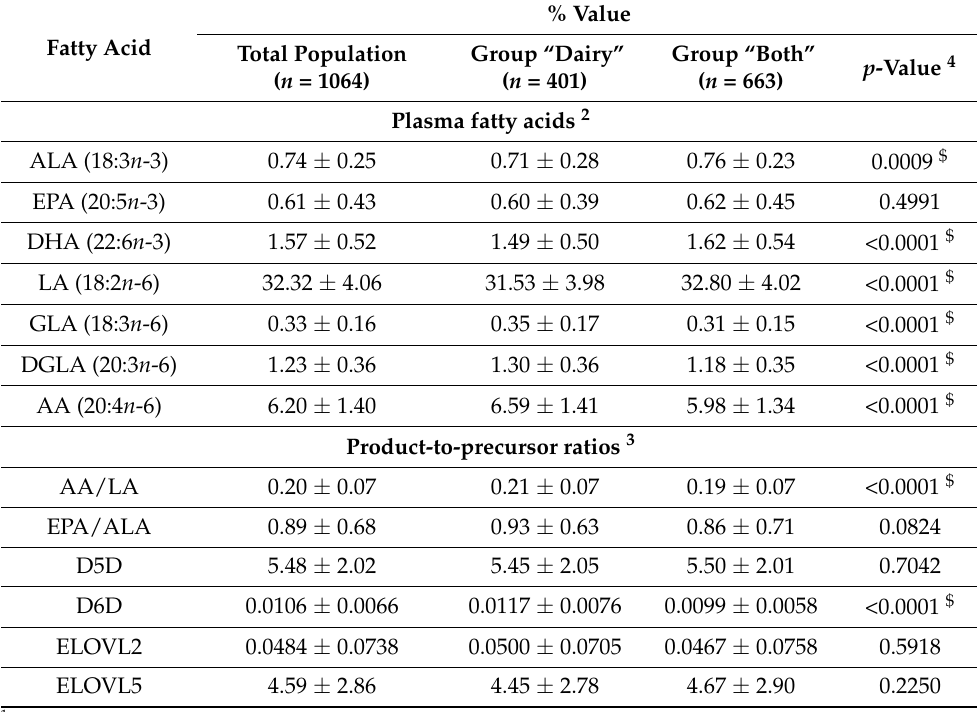
Table 4. Plasma polyunsaturated fatty acids and ratios by total dairy and total soy intake 1